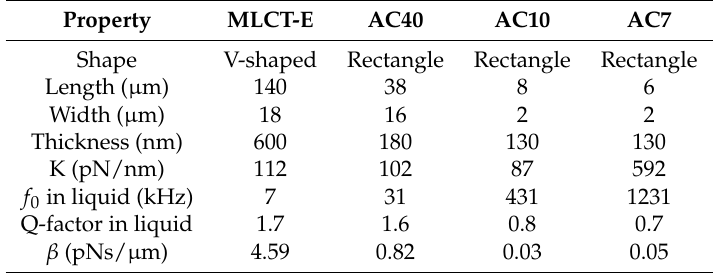
Table 2. The comparison of the properties of commonly available regular (MLCT-E and AC40) and ultra-short (AC10 and AC7) microcantilevers. Property MLCT-E AC40 AC10 AC7 Shape V-shaped Rectangle Rectangle Rectangle Length ( µ